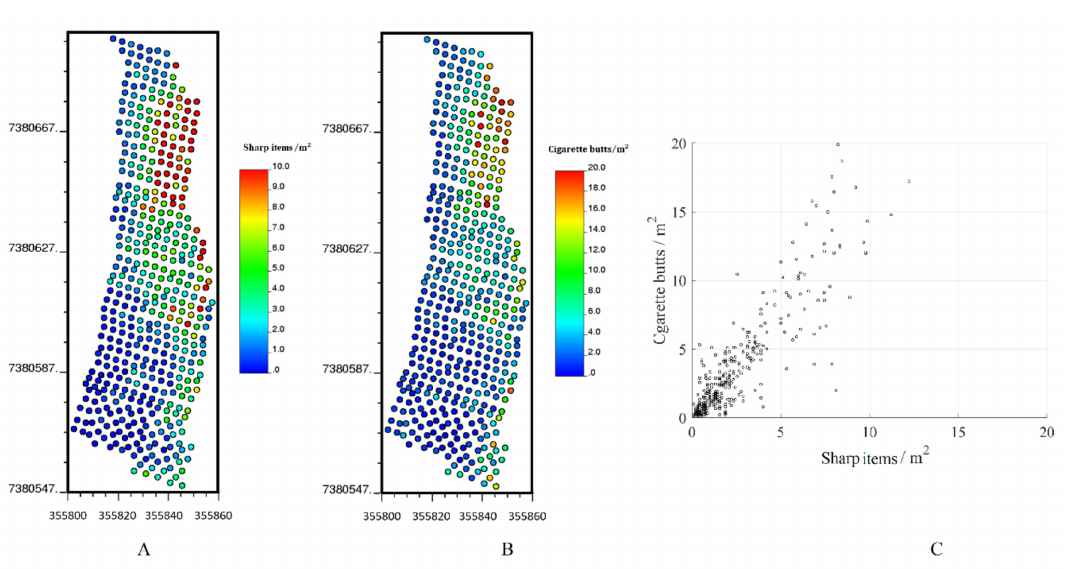
Figure 5. Location maps of sampling data: ( A ) cigarette butts, ( B ) sharp items. ( C ) Scatter plot between cigarette butts and sharp